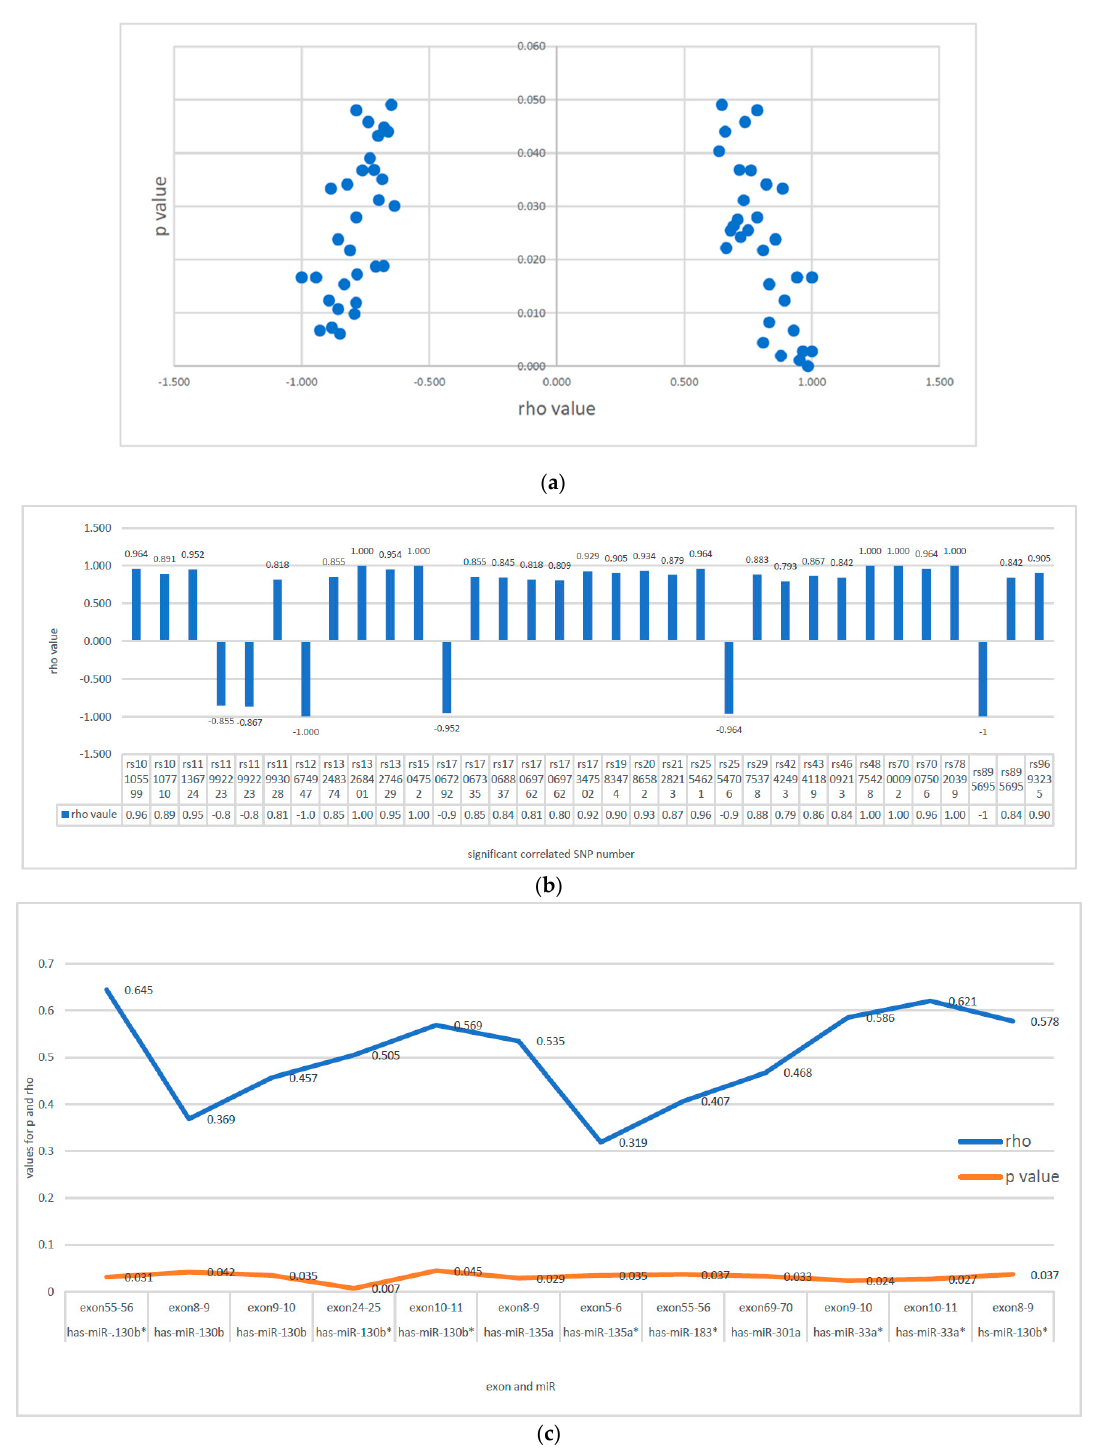
Figure 4. ( a ) Scatter chart of significant correlations between somatic CNAs in SNPs and mRNA expression of CSMD1 in ESCC. Negative rho values on left side indicate inverse correlations; positive rho values on right side indicate positive correlations. ( b ) Significant correlations between SNPs with alterations and miR expression ( p < 0.05). The y-axis is rho value, and the x-axis is the signifi- cantly correlated SNP. Each blue bar presents one correlation. ( c ) Significant correlations between expressions of CSMD1 and its target miRNAs in ESCC. The x-axis shows exon number and target miR number; y-axis shows rho value (blue line) and p -value (orange line). 3.7. CSMD1 Expression and Target miRNAs in ESCC Patients with and without Somatic DNA Alterations ESCC cases with DNA alterations had higher expression levels of CSMD1 than those without such alterations in most of the exons (9 of 11 boundaries), especially at exons 4–5 (average FC 15.69 vs. 1.95, or 8x higher) and exons 8–9 (average FC 19.37 vs. 3.47, or 5.6x higher) (Supplementary Table S7a and Figure 5a). A total of 16 of the 22 CSMD1 target miRNAs showed higher expression levels in patients with DNA alterations than those without (e.g., miR-190 (average FC 27.34 vs. 0.48, or 57x higher), miR-135b (average FC 22.5 vs. 2.93, or 7.7x higher), miR-449a (average FC 41.71 vs. 6.31, or 6.6x higher), and miR- 449b (average FC 5.4 vs. 0.17, or 6.9x higher)). In contrast, four miRNAs were expressed at lower levels in patients with DNA alterations than those without (e.g., miR-190b (aver- age FC 2.9 vs. 37.07, or 0.08x lower)) (Supplementary Table S7b; Figure 5b). These results